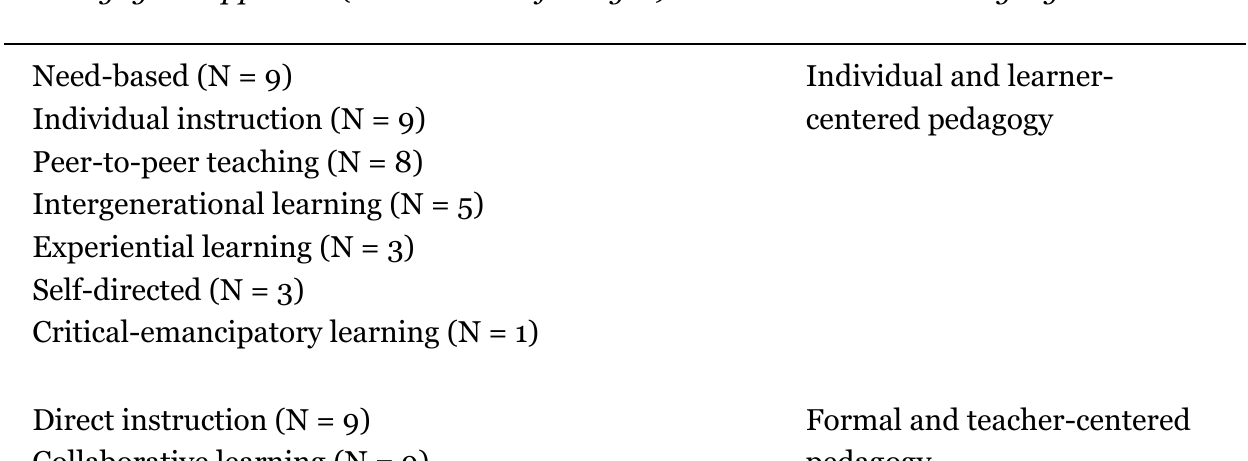
Table 1 Pedagogical approaches based on code classification Pedagogical approach (N = number of designs) Clustered category